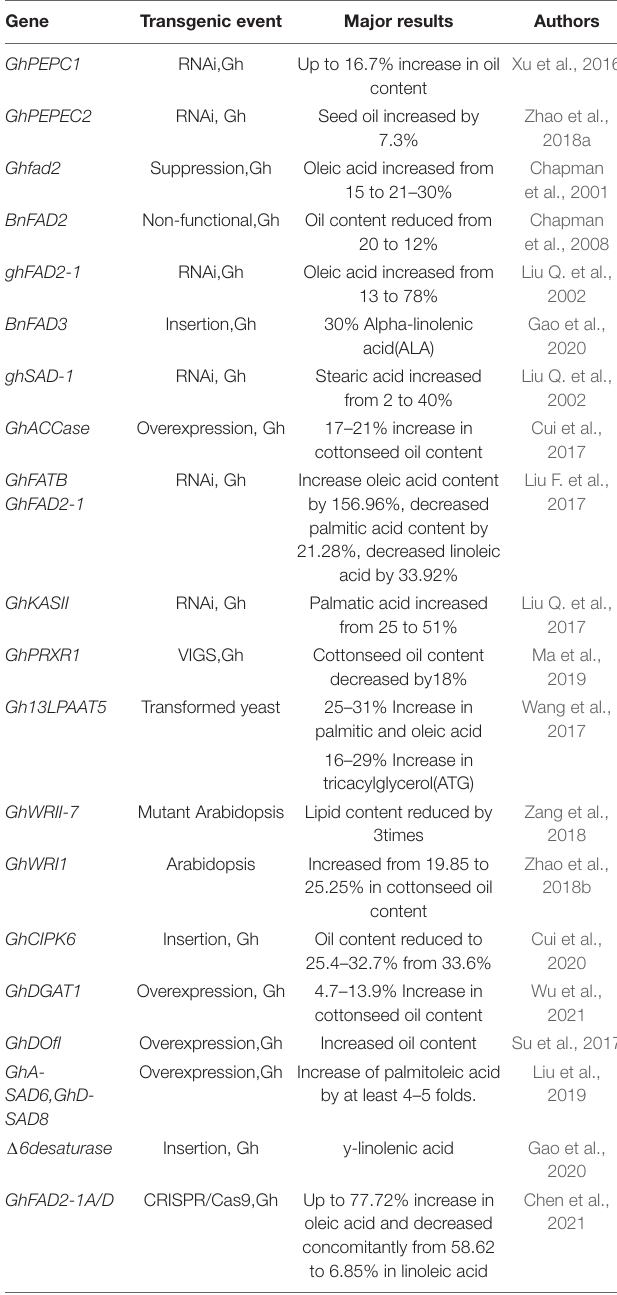
TABLE 2 | Genes used in genetically engineering cotton for improvement of cottonseed